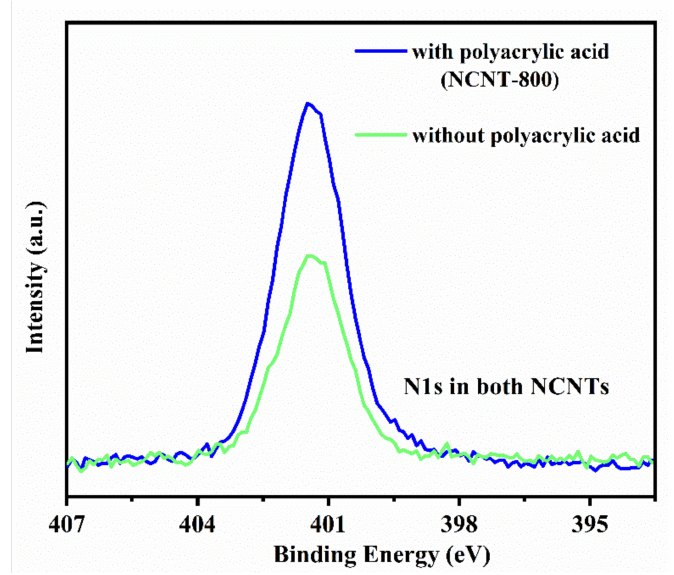
Figure 4. The percentage of N atoms for both samples of NCNTs treated under 800 ◦ C with and without adding the polyacrylic acid evaluated by The XPS measurements.